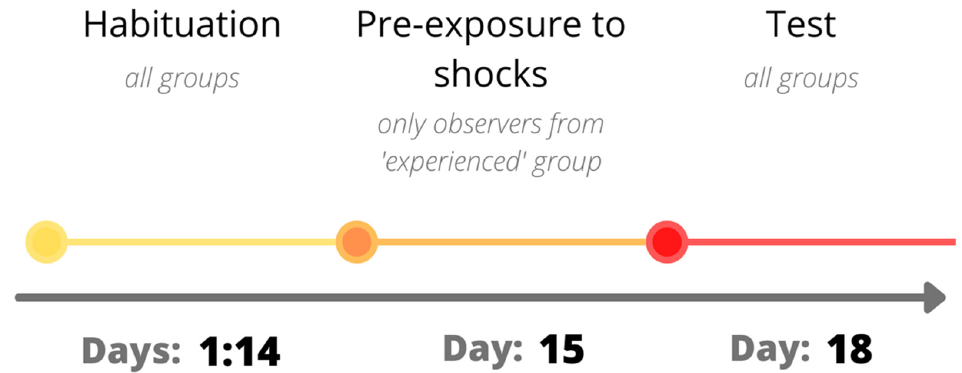
Figure 1. A graphic representation of the experimental design.